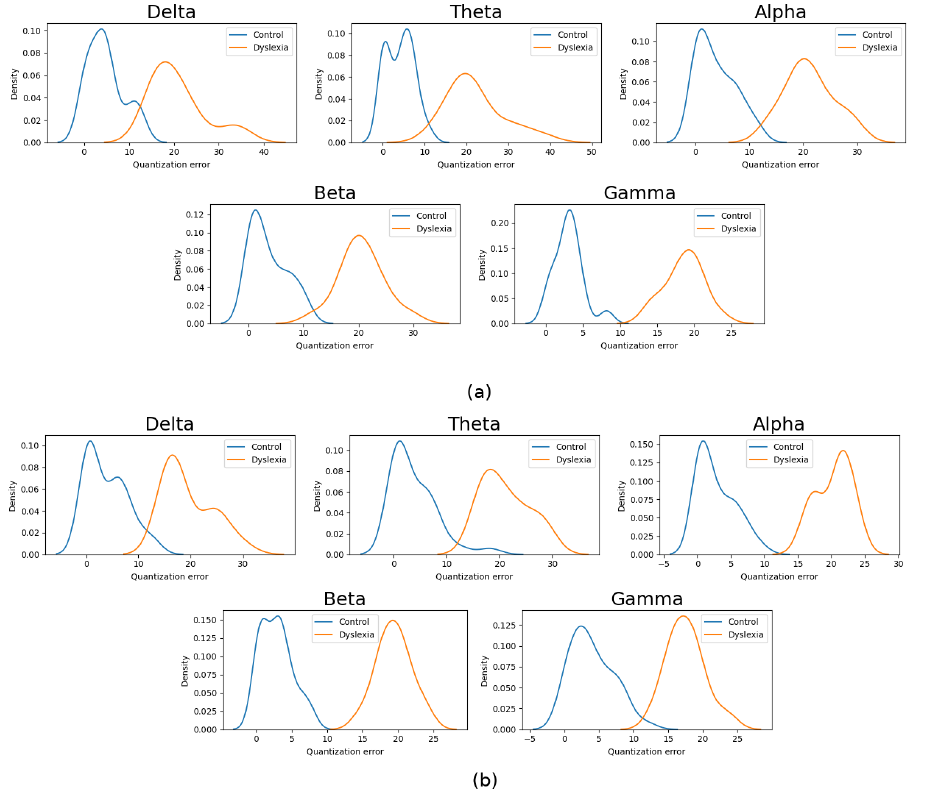
Figure 3. Quantization error distribution for Controls and Dyslexia subjects. The ( a ) 4.8 Hz and ( b ) 16 Hz